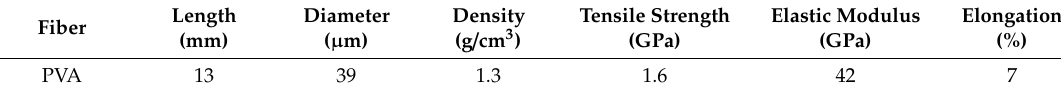
Table 2 . The properties of polyvinyl alcohol (PVA) fibers.